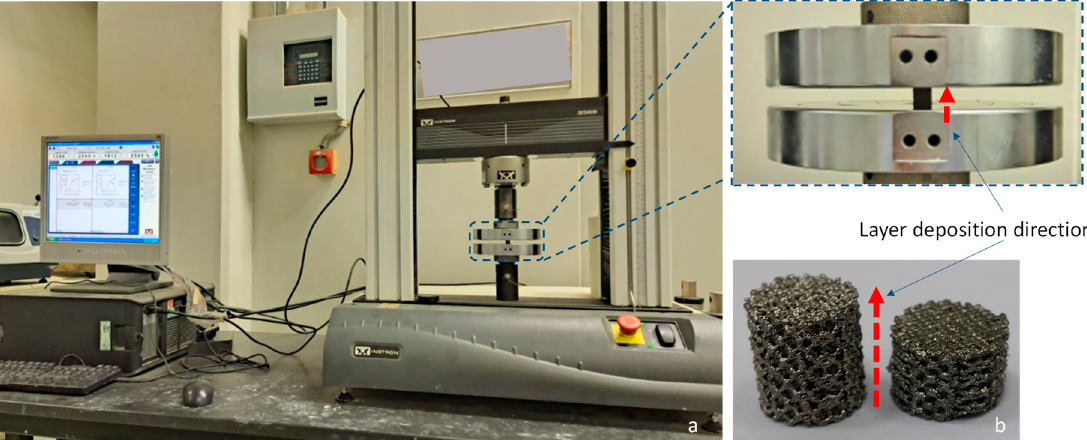
Figure 8. ( a ) Compression test performed on the cylindrical scaffolds and ( b ) cylindrical scaffold before and after compression tests. before and after compression